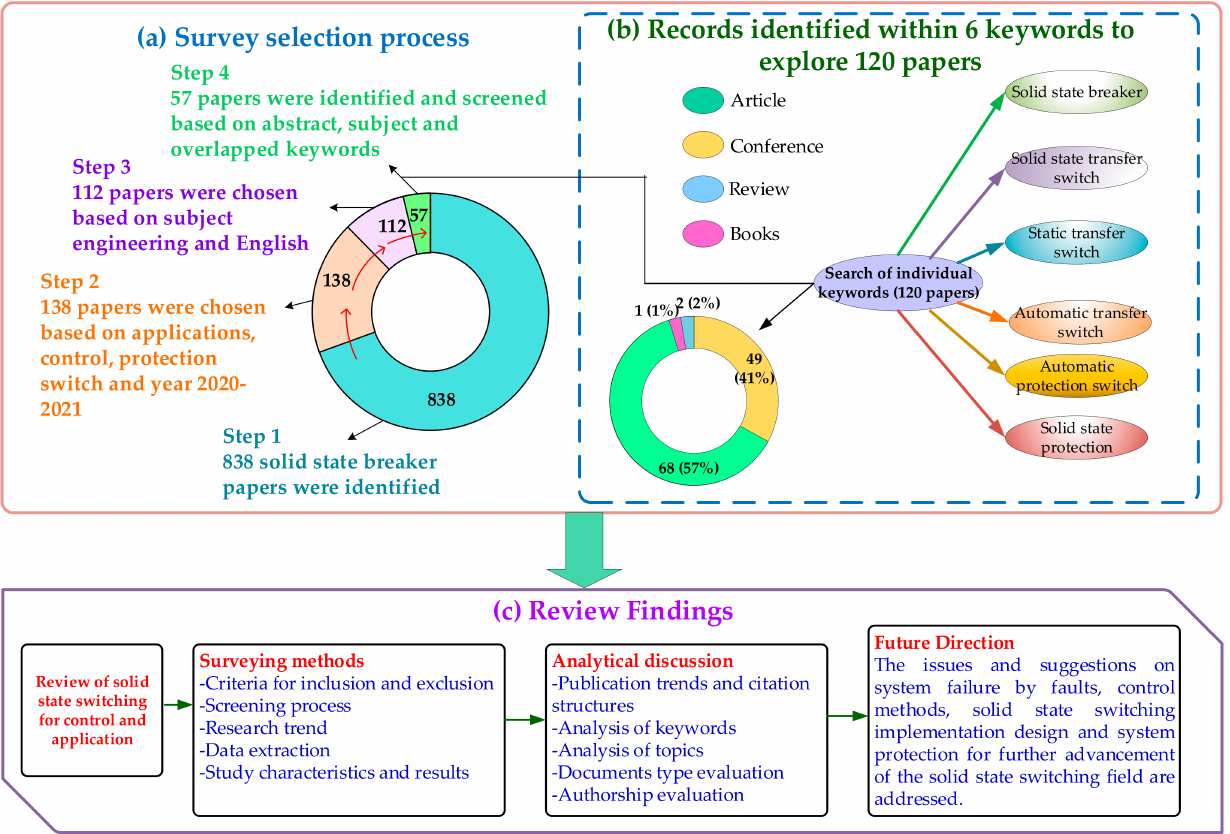
Figure 1. Surveying methods in the Scopus